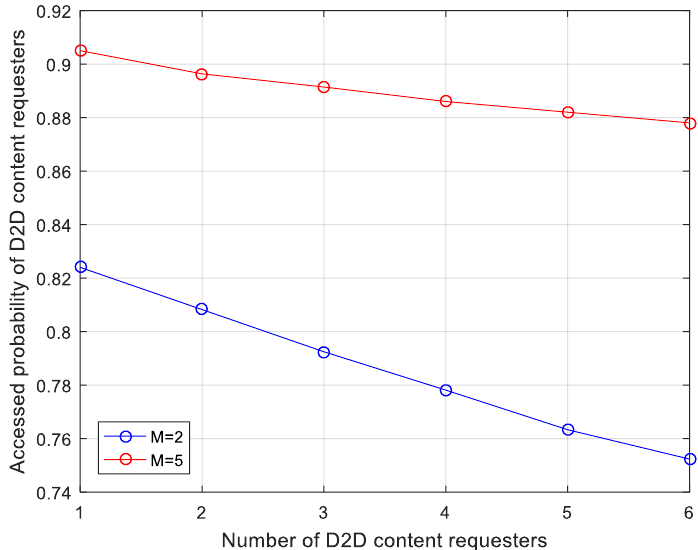
Figure 6. Accessed probability for different numbers of cellular channels with different numbers of D2D content requesters, K = 200 .